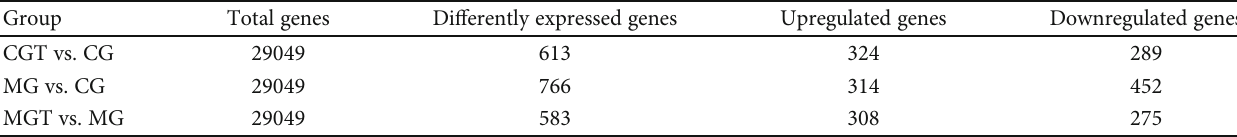
Figure 5: MAPK signaling pathways related to LXTYF for AICH. KEGG ID=hsa04010, enriched with 49 genes. Table 3: Number of genes expressed in each group of RNA-seq